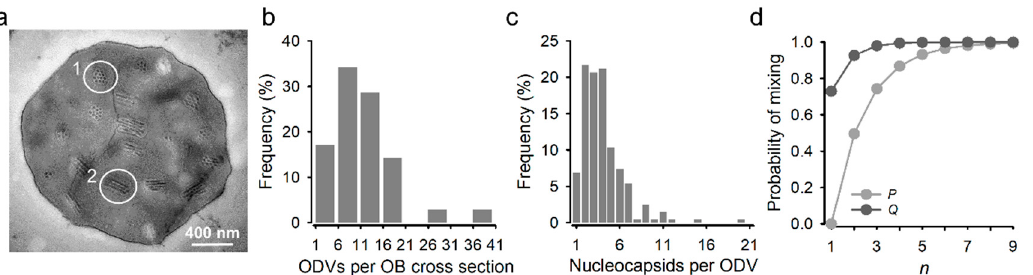
Figure 2. ODV and nucleocapsid content of AcMNPV OBs. ( a ). Transmission electron micrography of an OB obtained from Sf21 cells coinfected with the GFP- and Cherry-expressing variants at an MOI of 5 PFU/cell and harvested at 6 dpi. ODVs appear in transverse (1) and longitudinal (2) sec- tions. ( b ). Distribution of the observed number of ODVs per OB cross section. ( c ). Distribution of the number of nucleocapsids per ODV. Only transverse sections were used for determining this distribution. ( d ). Probability that an ODV ( P , light grey) or OB ( Q , dark grey) contains a mixture of nucleocapsids from both types (GFP and Cherry) assuming free assortment of the two variants in coinfected cells. P depends on the number of nucleocapsids per ODV (shown as n in the x-axis). To calculate Q , we integrated P over the observed distribution of the number of nucleocapsids per ODV, shown in c. Q further depends on the number of ODVs per OB (also represented as n in the x-axis). See methods for calculation details.